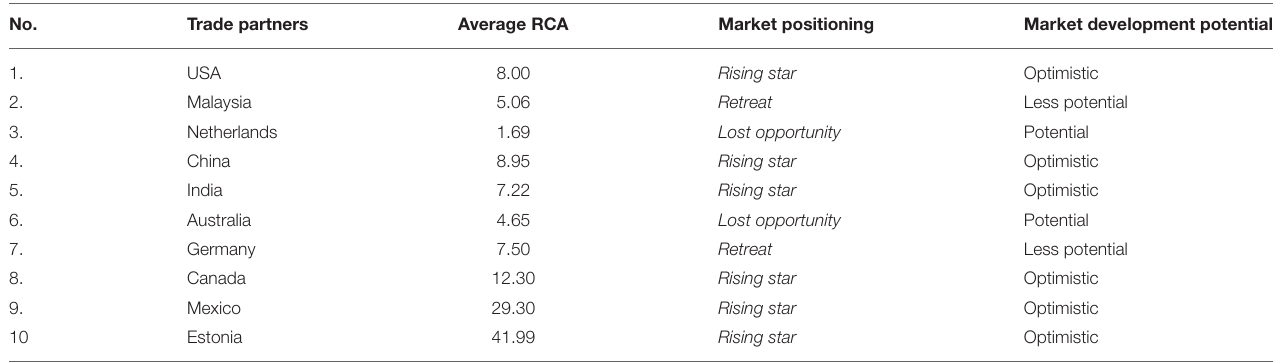
TABLE 5 | Analysis results of the X-Model Potential Product of Indonesian cocoa to the 10 main trading partners in 2014–2018. No. Trade partners Average RCA Market positioning Market development